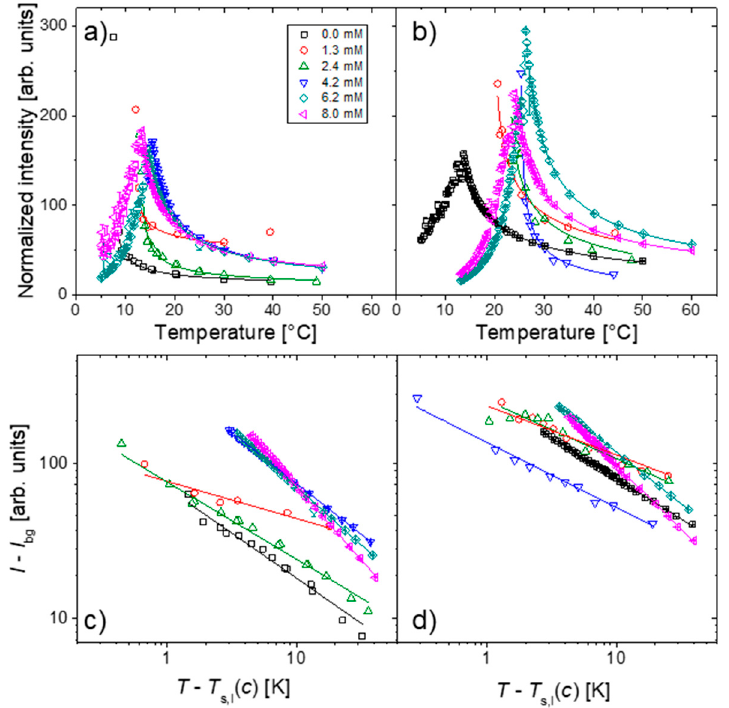
Figure 3. ( a , b ) Scattered intensities in relation to temperature; ( c , d ) Same intensity data in relation to reduced temperature, τ , in log-log representation. Symbols: experimental data as detailed in the legend of ( a ), lines: fits. ( a , c ) PSPP 85 , ( b , d ) PSPP 280 at 5 wt.% in H 2 O and at the NaBr concentrations indicated. The intensities are normalized to the incoming flux. The temperature range of the lines corresponds to the data points used for the fits. In ( c , d ), only points from the one-phase state are plotted, i.e., at temperatures on the higher side of the intensity maximum.